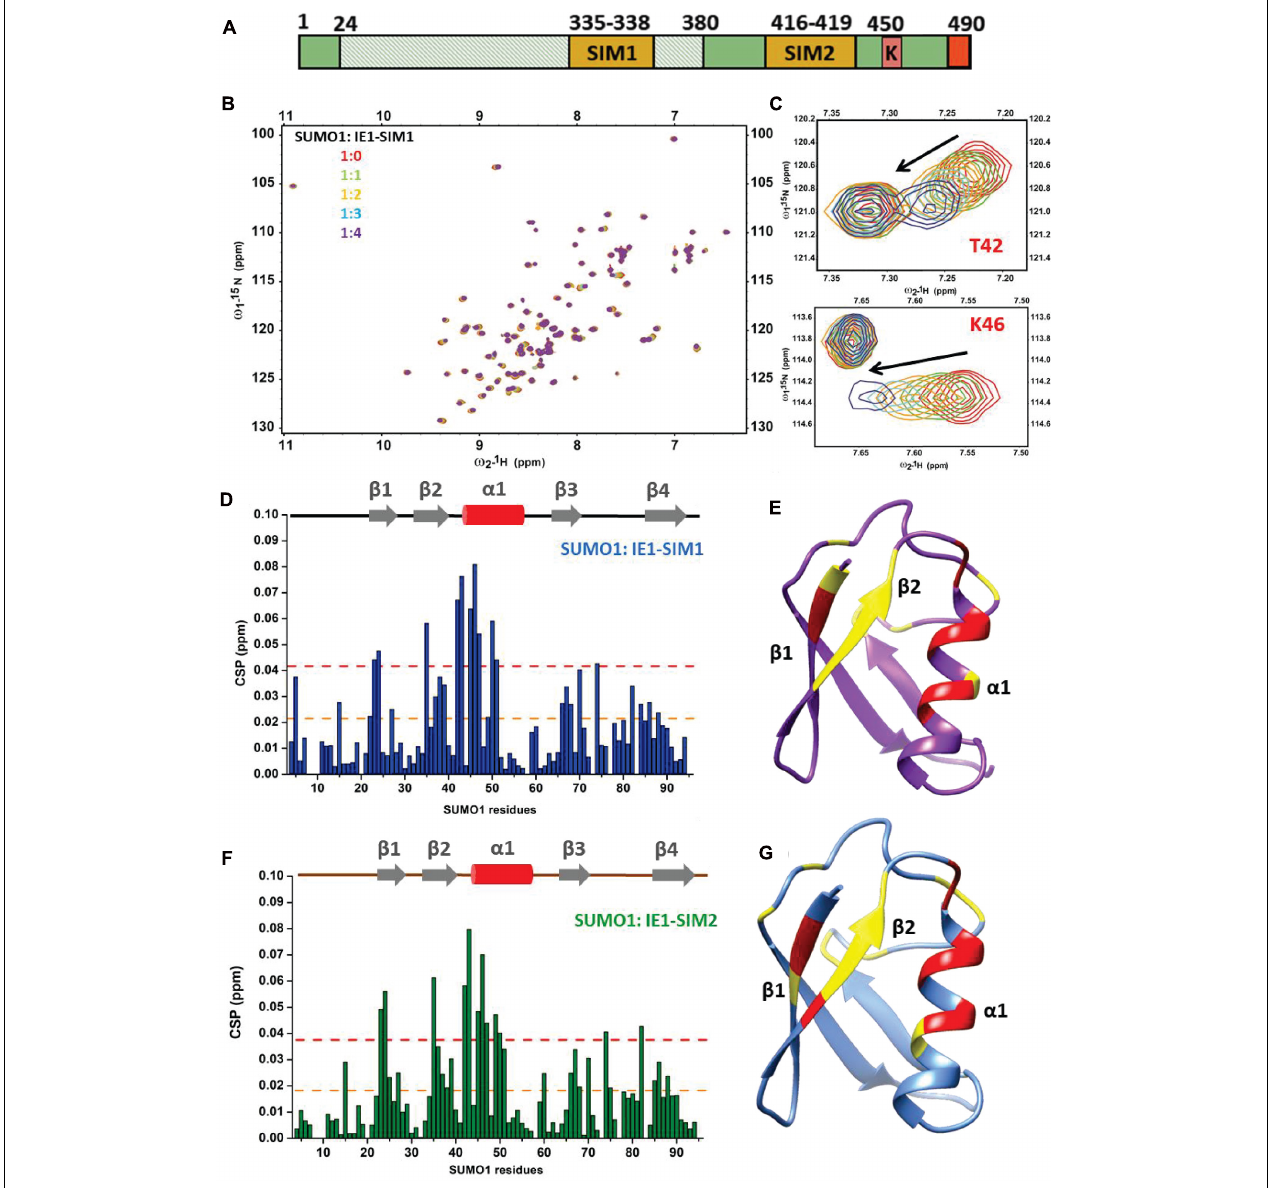
FIGURE 1 | Interactions between IE1-SIM1 and SUMO1. (A) Representation of functional domains and putative SIMs of IE1. The shaded area from aa 24–380 is the core domain of IE1, responsible for inhibiting PML SUMOylation and its transactivation activity. C terminal domain of IE1 contains the STAT2 binding region, SUMOylation site, and chromatin tethering domain (in red) (B) Overlay of the 1 H, 15 N-edited HSQC spectra of free 15 N-SUMO1 (red) with different stoichiometric ratios of IE1-SIM1. (C) Resonances of two residues of SUMO1 (T42 and K46) are expanded to show a shift of resonances during titration. (D) The CSPs upon binding to IE1-SIM1 are plotted against the residues of SUMO1. The CSPs are calculated as [( δ N bound – δ N free ) 2 /25 + ( δ H bound – δ H free ) 2 ] 1 / 2 , where δ N bound and δ N free are 15 N chemical shifts of the amide resonance in bound and free form, respectively. Similarly, δ H bound and δ H free are 1 H chemical shifts of the amide resonance in bound and free form. (E) The significant CSPs of IE1-SIM1 and SUMO1 binding are mapped onto the SUMO1 structure. (F) The CSPs upon binding to IE1-SIM2 are plotted against the residues of SUMO1. (G) The significant CSPs from (F) are mapped onto the SUMO1 structure. In (D,F) , the yellow dashed line indicates 1 × standard deviation, and the red dashed line indicates 2 × standard deviation. In (E,F) , the regions with CSPs above 1 × standard deviation were colored yellow, and those with 2 × standard deviation were colored